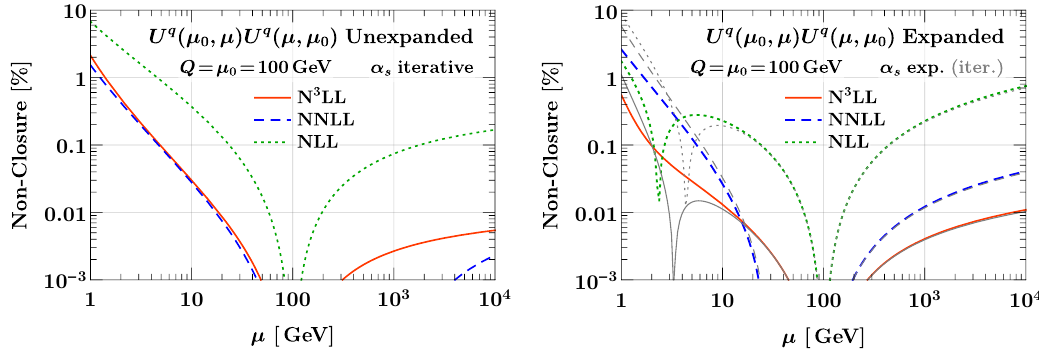
Figure 5 . Deviation from the closure condition U q ( (cid:22) 0 ; (cid:22) ) U q ( (cid:22); (cid:22) 0 ) = 1 for the quark evolution kernels from NLL to N 3 LL for the unexpanded method (left) and expanded method (right). For the expanded method, the gray lines show the result of using the iterative instead of the ex- panded (cid:11) s ( (cid:22) 0 ).